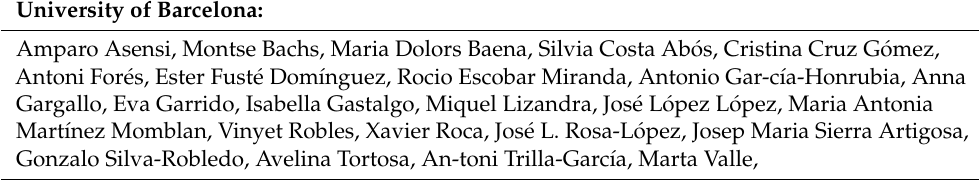
Table A2. Members of the UB-GTMS COVID-19